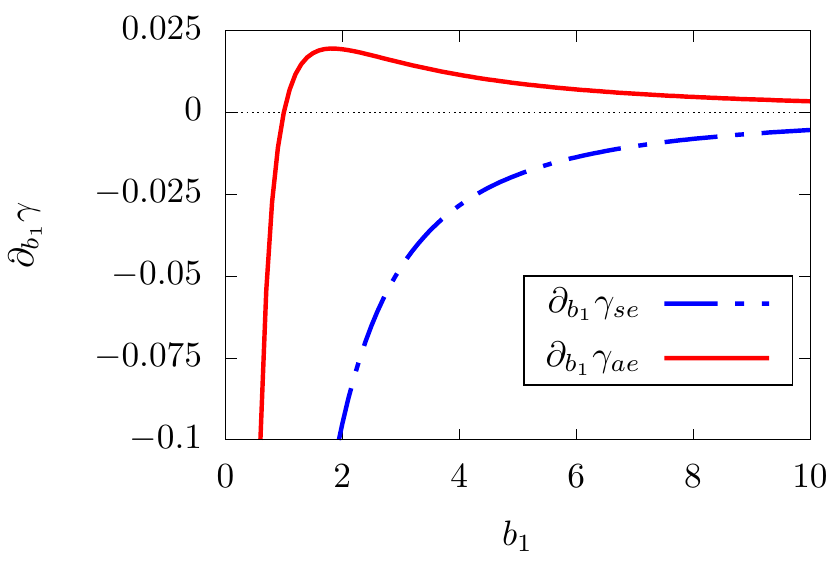
Figure 10 . The quantity ∂ b γ se is plotted with respect to varying b 1 for accelerated atoms in 1 thermal background in (1+3) dimensions, depicted by dash-dotted blue line. The quantity ∂ b plotted with respect to varying b 1 for accelerated atoms in thermal background in (1+3) dimensions, depicted by solid red